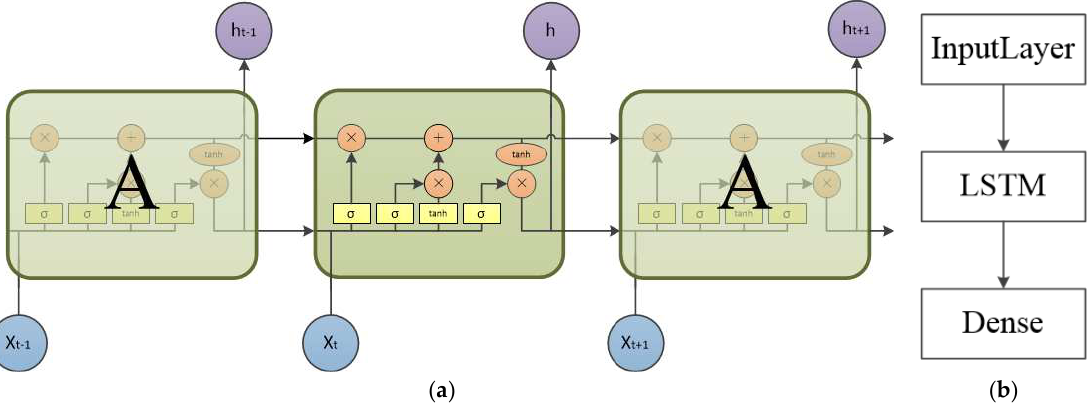
Figure 6. LSTM cell structure ( a ) and prediction model structure ( b ).